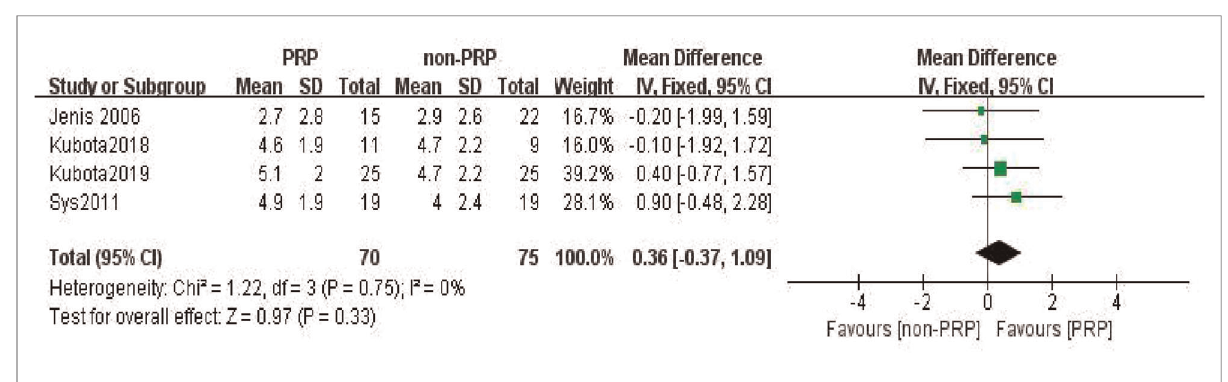
FIGURE 5 Forest plot of the VAS changes at the 24th postoperative